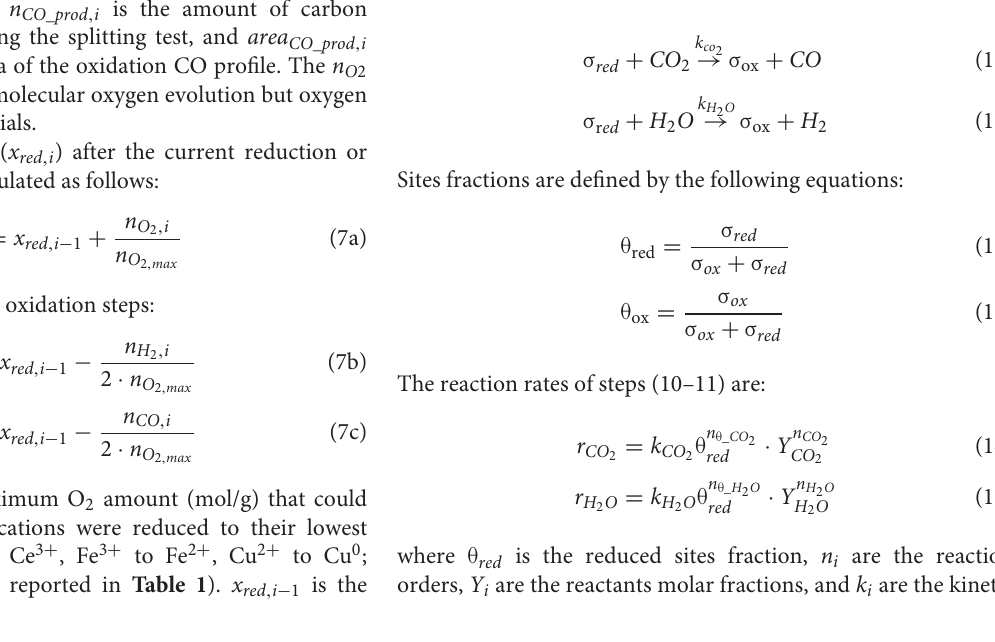
TABLE 1 | Materials tested for the thermochemical splitting process, including nominal compositions (molar ratios), general formulas, and maximum oxygen evolutions (mmol/g).